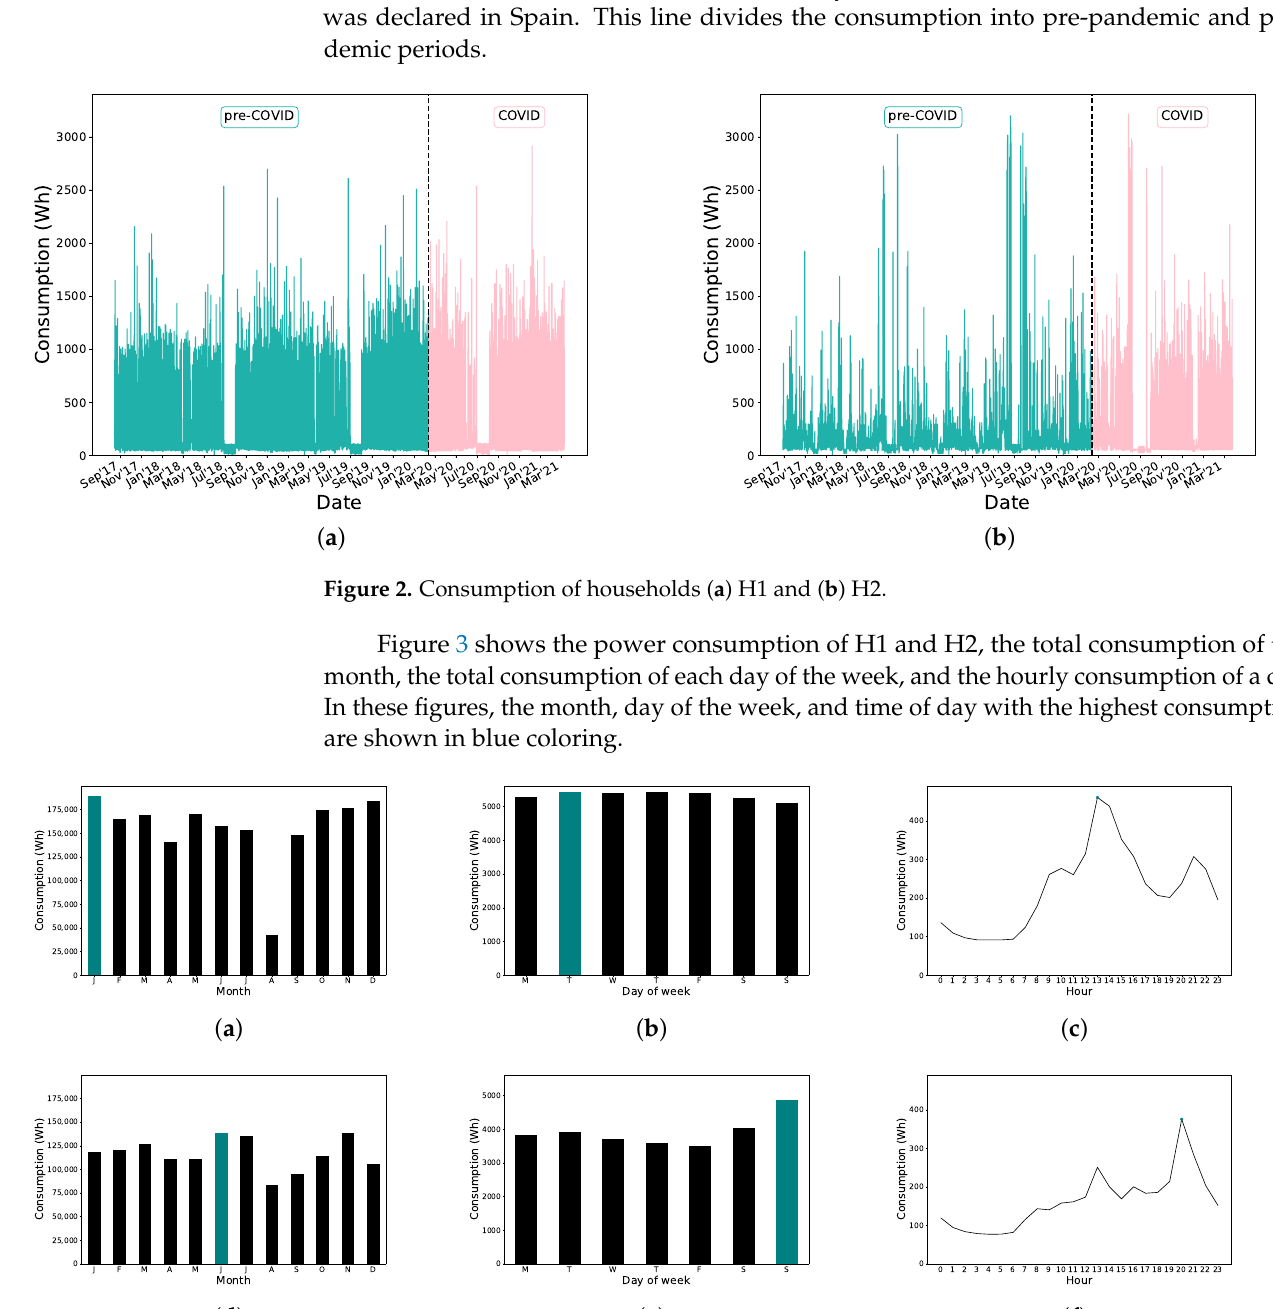
Figure 3. Average load curves. ( a ) H1 (monthly). ( b ) H1 (daily). ( c ) H1 (hourly). ( d ) H2 (monthly). ( e ) H2 (daily). ( f ) H2 (hourly). In both households, the month with less power consumption was August, but the month with more consumption in H1 was January and in H2 was June. This explanation lies in the presence of an air conditioner in H2, while H1 had no air conditioner. In H1, consumption was evenly distributed among all days of the week, and consumption was higher at midday. In H2, consumption on weekends was higher than during the labor days, and in the daily consumption curve, we can observe that the peak occurred in the evening. The dwellers of H2 had a full working day and ate away from home during the